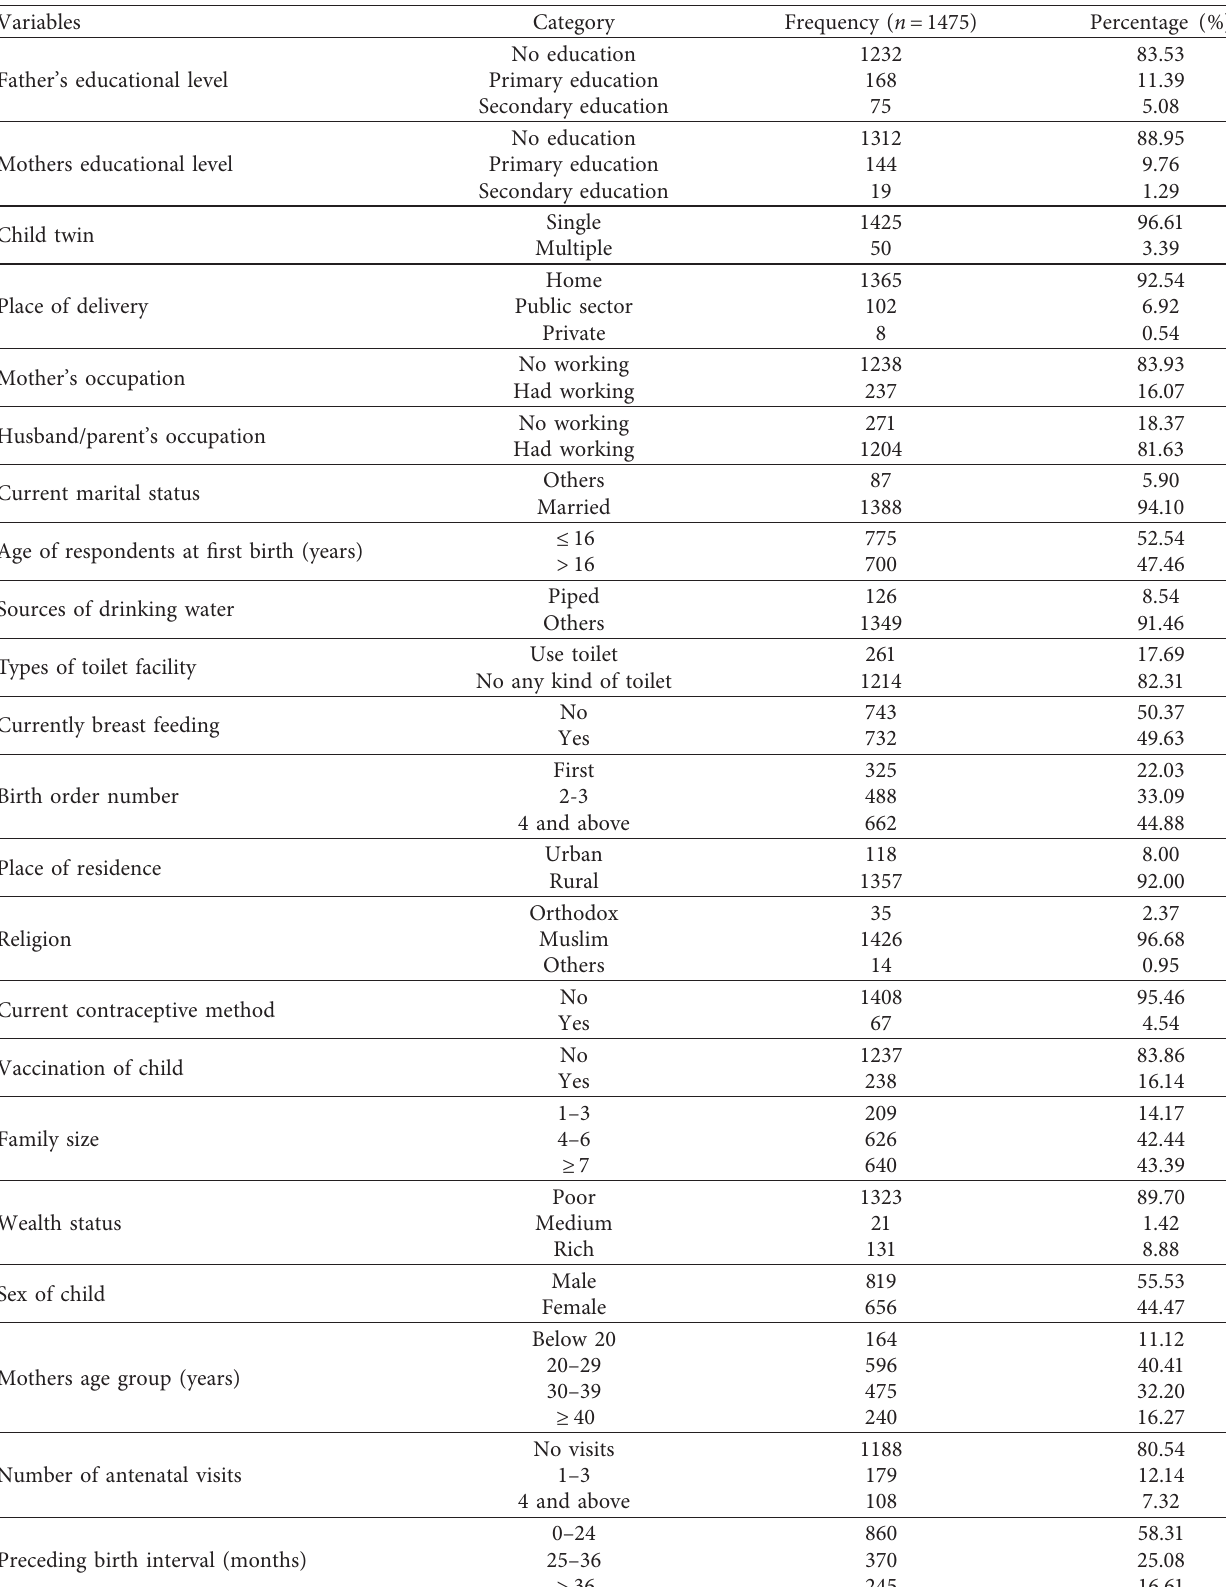
Table 1: Sociodemographic and economic characteristics of children (0–59 months) and their mother in Afar Region, Ethiopia ( n � 1475).